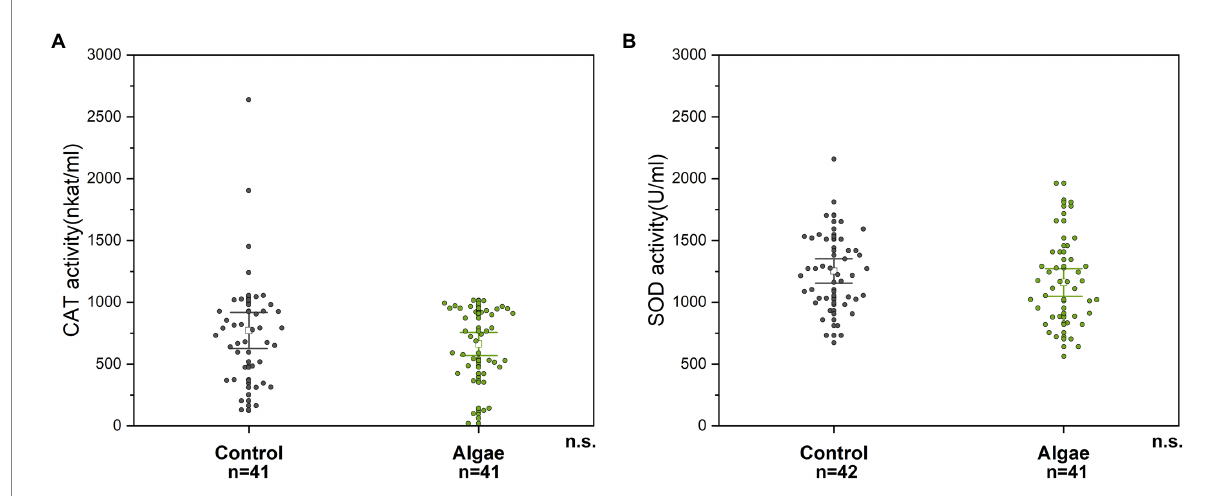
FIGURE 4 CAT (A) and SOD (B) enzyme activity in bee abdomen extracts; n. s. – the non-significant difference between tested groups. Control – bees from colonies fed with APIVITAL® sugar syrup. Algae – bees from colonies fed with 10% (w/v) Chlorella powder in APIVITAL® sugar